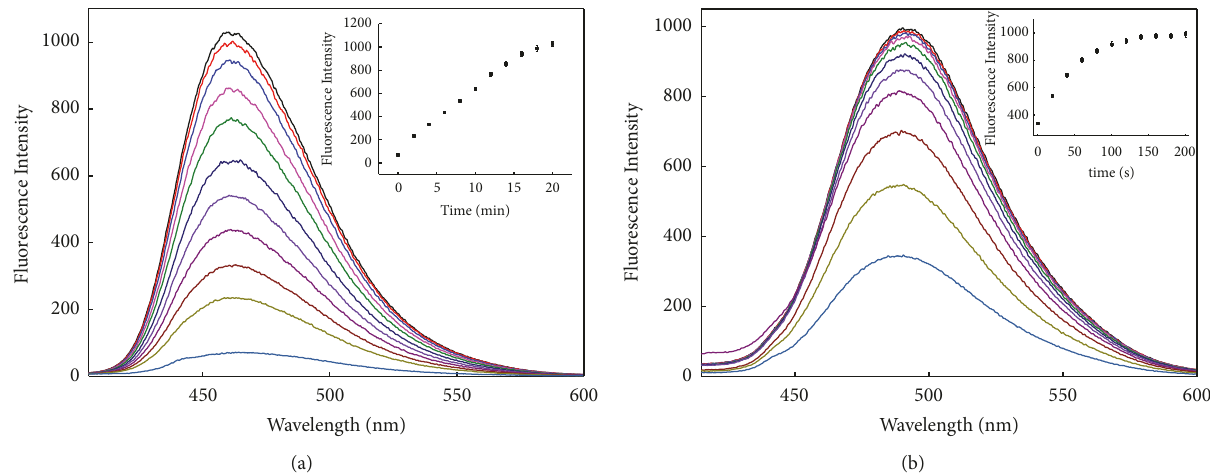
Figure 1: Change of fluorescence spectra with time for the reactions of DDQ and biothiols in the ethanol system. (a) DDQ (10 𝜇 M) with Hcy (0.1mM), (inset) change of fluorescence intensity with time at 467 nm. (b) DDQ (10 𝜇 M) with GSH (1mM), (inset) change of fluorescence intensity with time at 494nm.